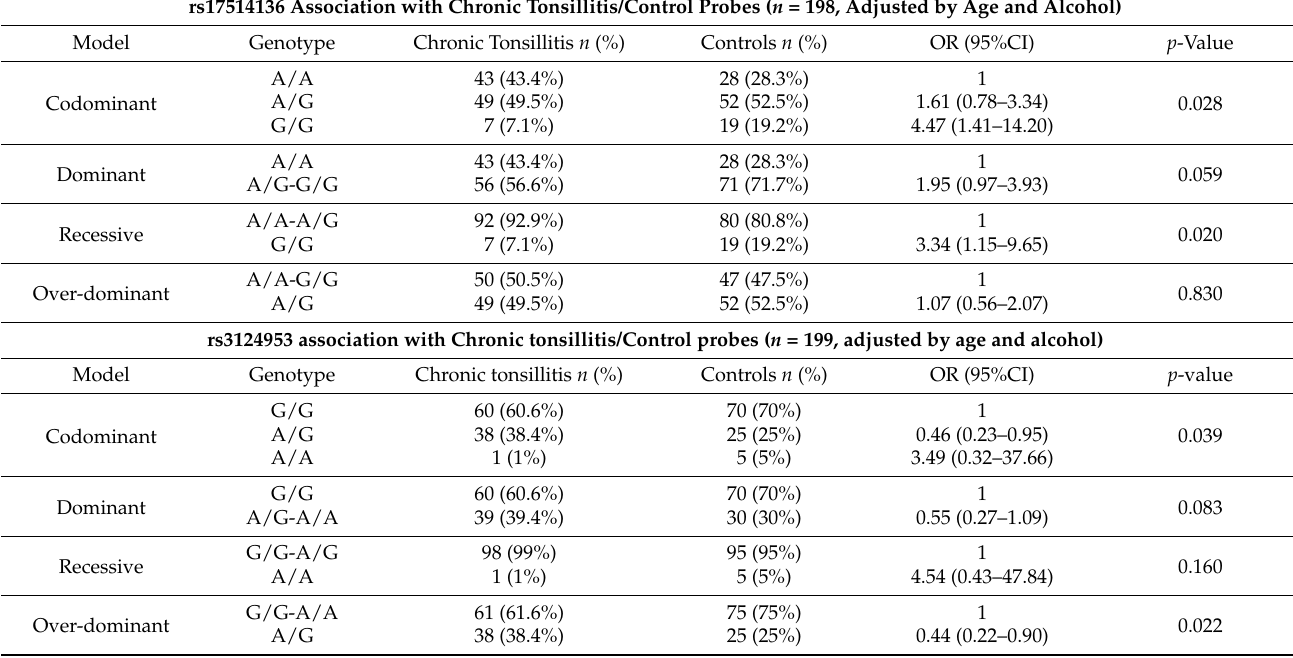
Table 5. Different-models analysis of frequency of FCN2 genotypes in patients with chronic tonsillitis and